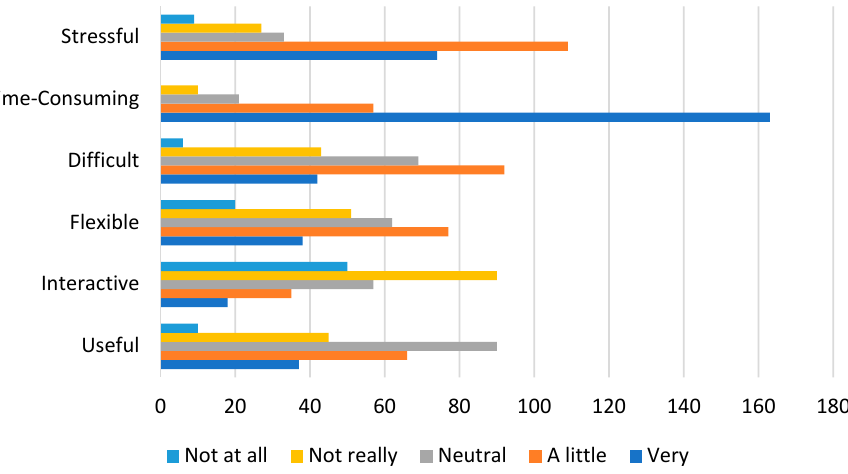
Figure 1. Responses to the survey question: “How did you find online teaching when you first began?” ( n = 248–252).